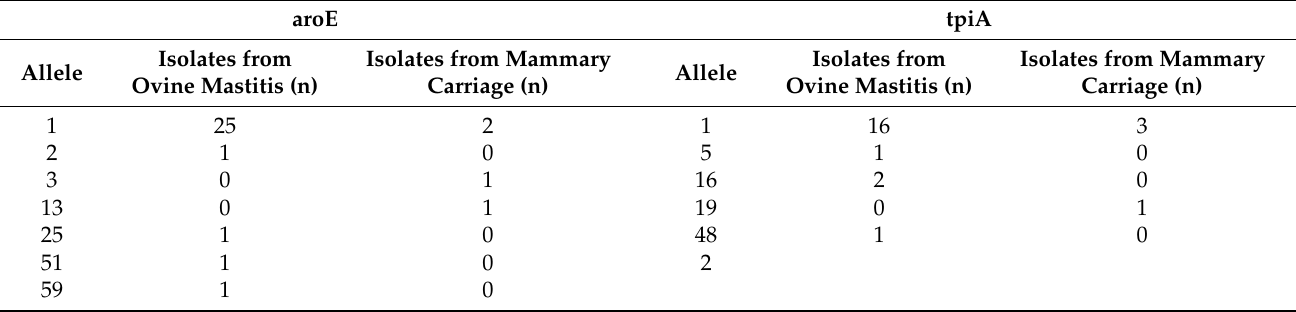
Table 3. Frequency of alleles of the genes aroE and tpiA in S. epidermidis isolates from cases of ovine mastitis ( n = 33) or ovine mammary carriage ( n = 4) in the MLST database, recovered in